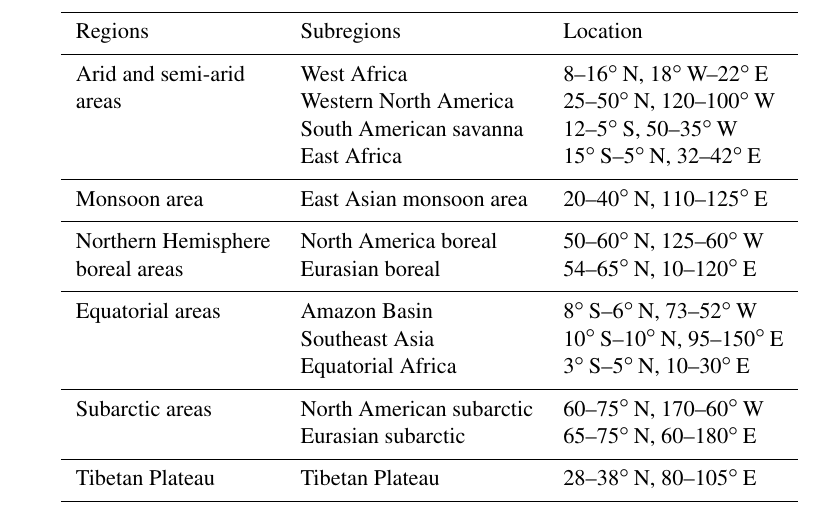
Table 2. Location for study areas.